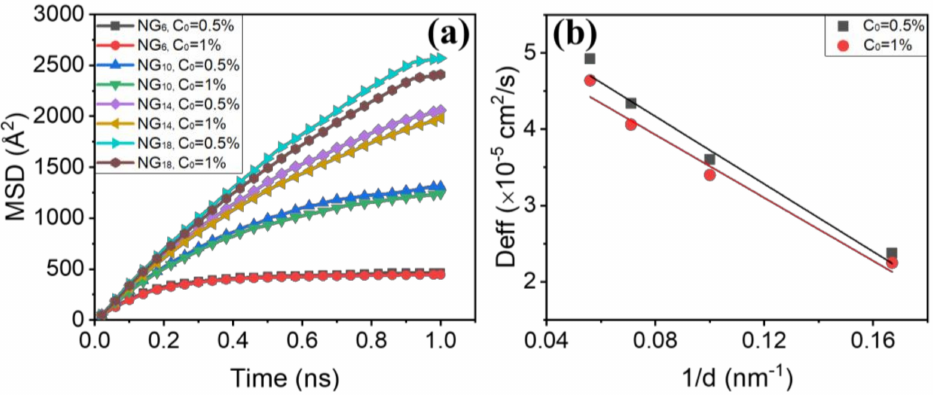
Figure 2. ( a ) MSD of H atoms in models with different grain sizes vs. time; ( b ) D ef f as a function of